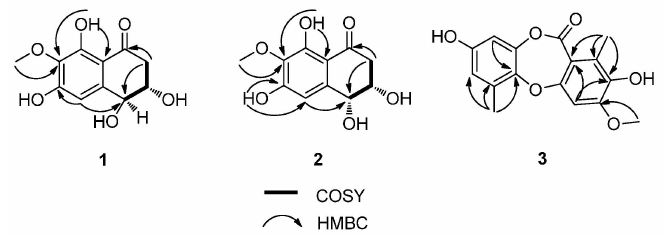
Figure 2. COSY Correlations and Key HMBCs of 1 , 2 , and 3 .